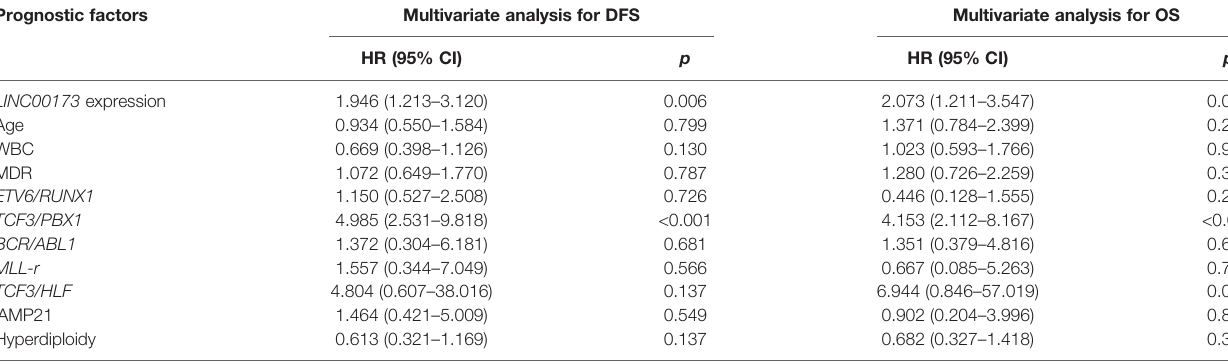
TABLE 2 | Multivariate analyses of prognostic factors for disease-free survival and overall survival in the TARGET cohort. Prognostic factors Multivariate analysis for DFS